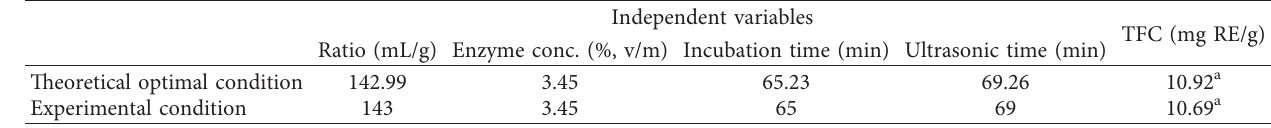
Table 5: Predicted and experimental values of the responses at optimal conditions 1,2 .